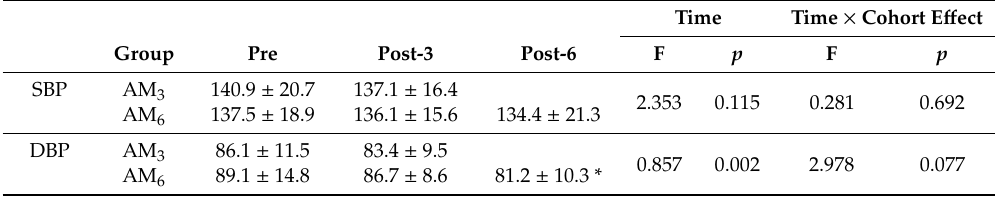
Table 5. Systolic and Diastolic blood pressure before the exercise program and after follow up.